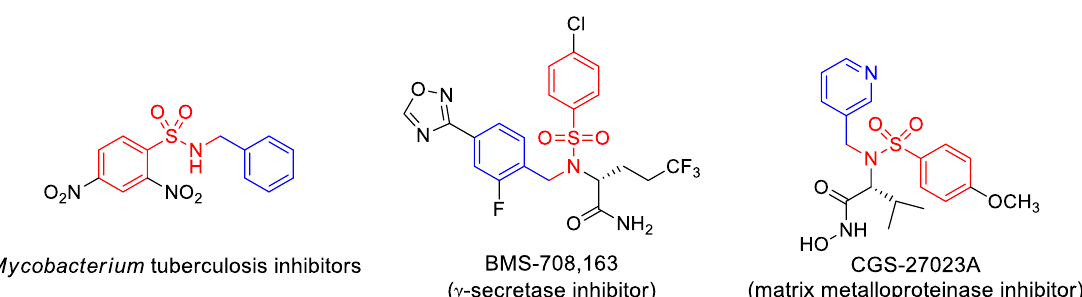
Figure 1. Selected examples of bioactive benzylic N -alkylsulfonamide pharmacores.